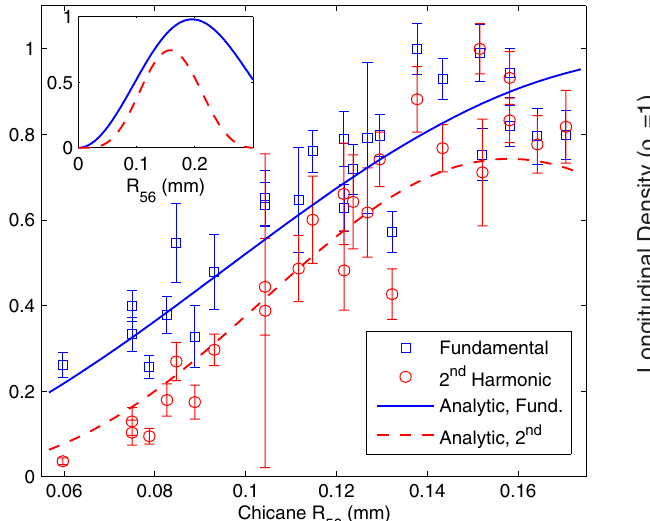
FIG. 4. (Color) A scan of the chicane R harmonics are shown together with the analytic form overlayed. Each data point represents a run of 500 events, fitted with errors found by the boot-strap technique. The inset shows the analytic function for the COTR output [Eq.